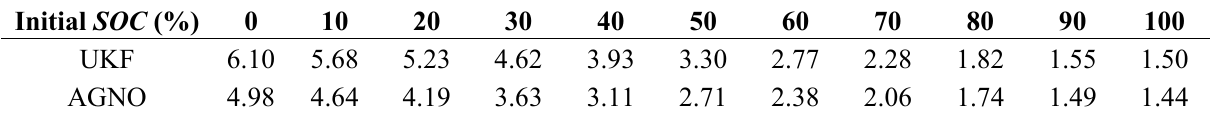
Table 2. Comparison of RMSEs (%) with different intial SOC s under NEDC